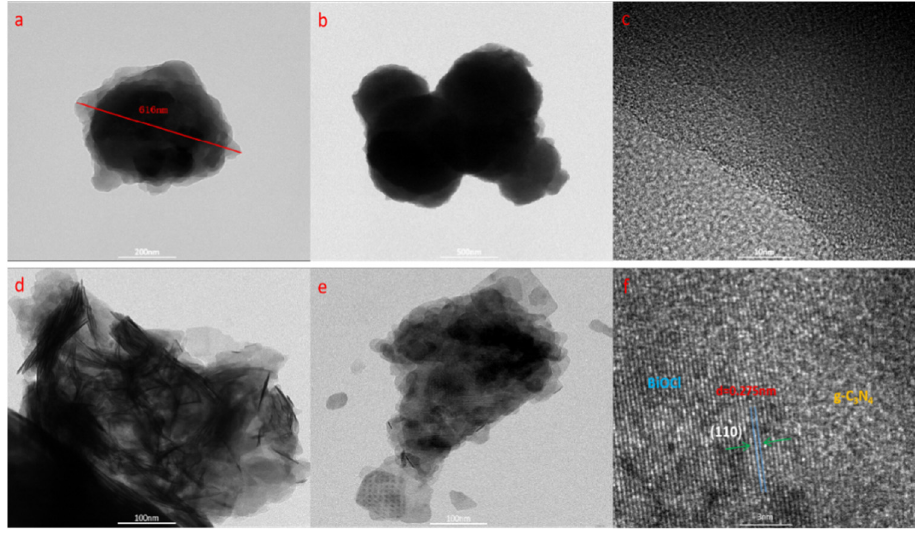
Figure 5. TEM of g-C 3 N 4 and CB-3: ( a – c ) g-C 3 N 4 , ( d – f ) CB-3.